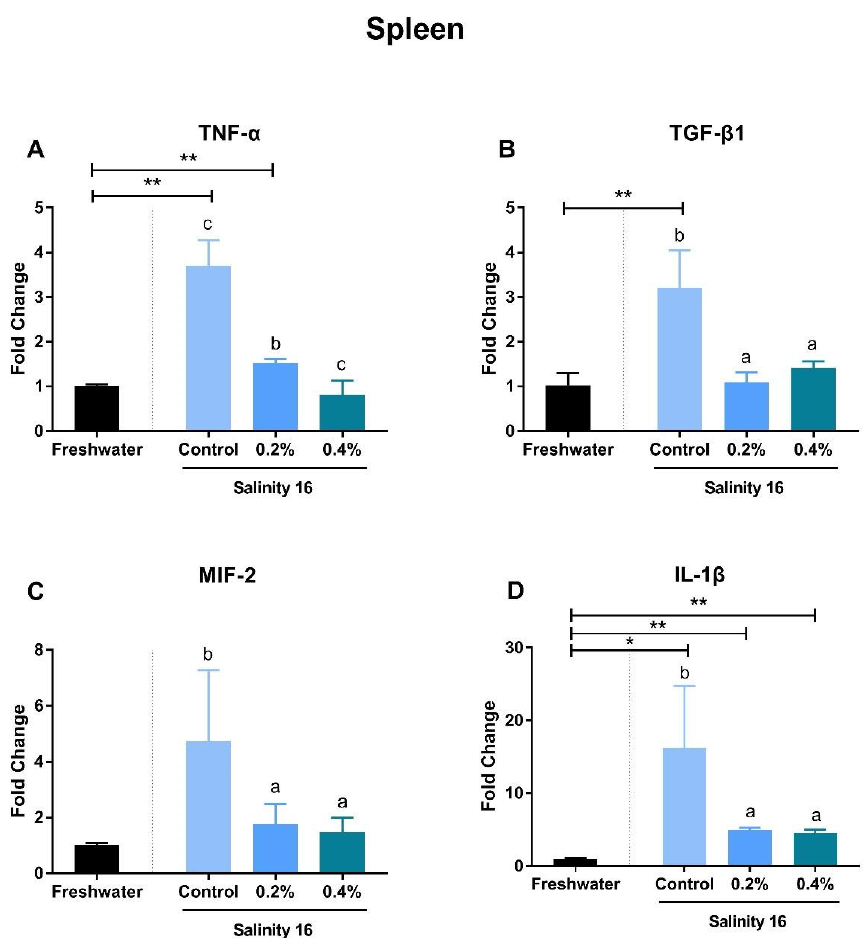
Figure 2. The gene expression of TNF- α ( A ), TGF- β 1 ( B ), MIF-2 ( C ), and IL-1 β ( D ) in the spleen of O. niloticus fed diets with β -glucan in freshwater and brackish water. A single asterisk (*) indicates a significant difference ( p < 0.05) and two asterisks (**) indicate an extremely-significant difference ( p < 0.01). Different letters with a–c indicated significant differences among three treatments in 16 salinity water ( p < 0.05).